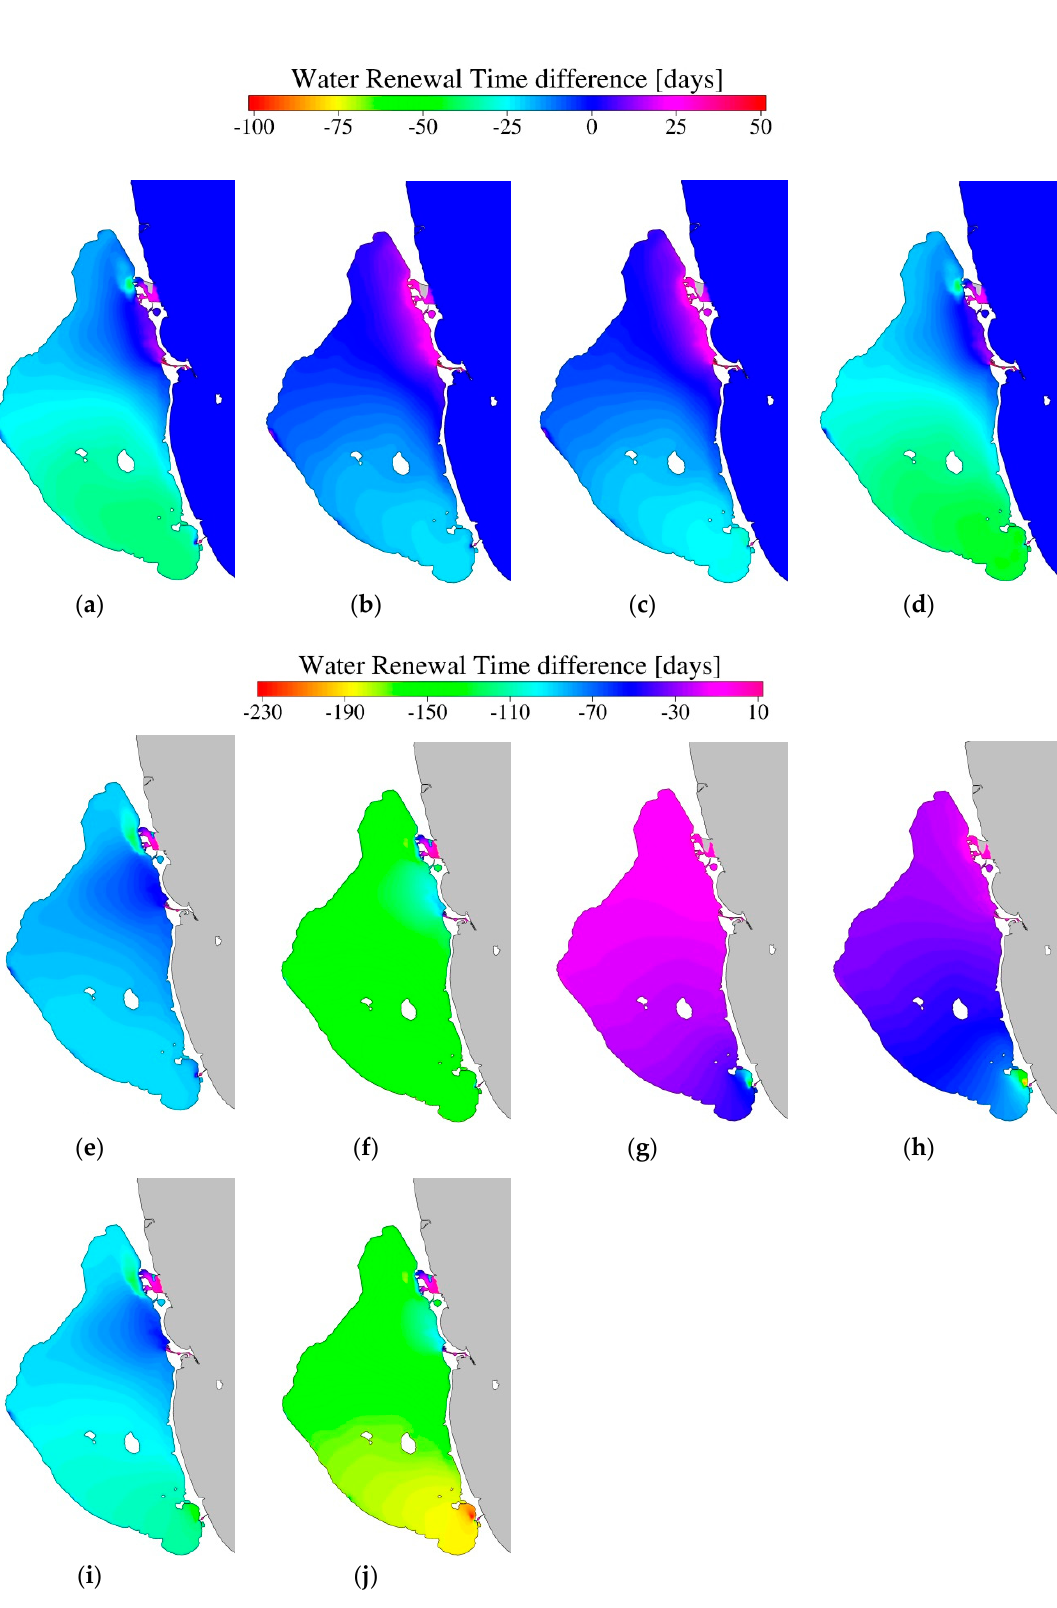
Figure 16. Water renewal time differences with respect to Undisturbed state: ( a ) Maint_Enc; ( b ) Mar_part_0.5m; ( c ) Mar_0.5m; ( d ) Maint_Enc_Mar_0.5m; ( e ) Enc_1m; ( f ) Enc_1.5m; ( g ) Mar_1m; ( h ) Mar_1.5m; ( i ) Enc_Mar_1m; ( j ) Enc_Mar_1.5m.